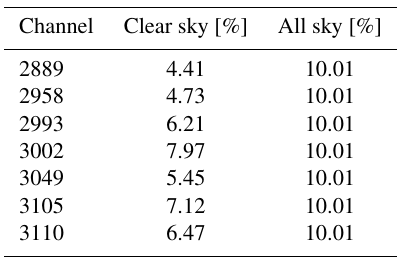
Figure 3. Percentage of actively assimilated IASI observations in clear skies in (a) channel 2889 and (b) channel 3002 and (c) in all channels for all-sky assimilation, from 1 to 20 June 2017. Table 2. Global percentage of observations remaining for assimila- tion in the IASI WV channels during 1–20 June 2017.